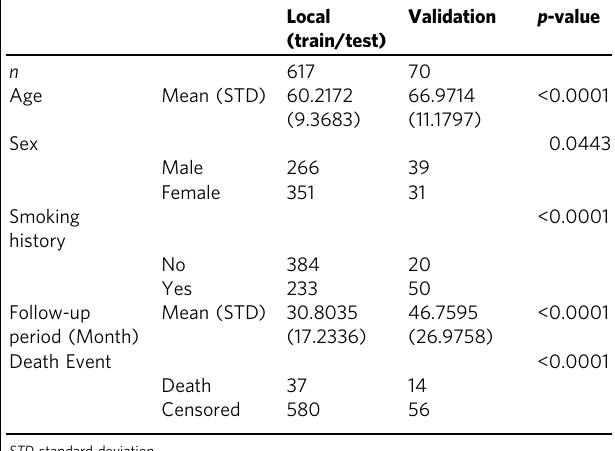
Table 6 Demographic information of study